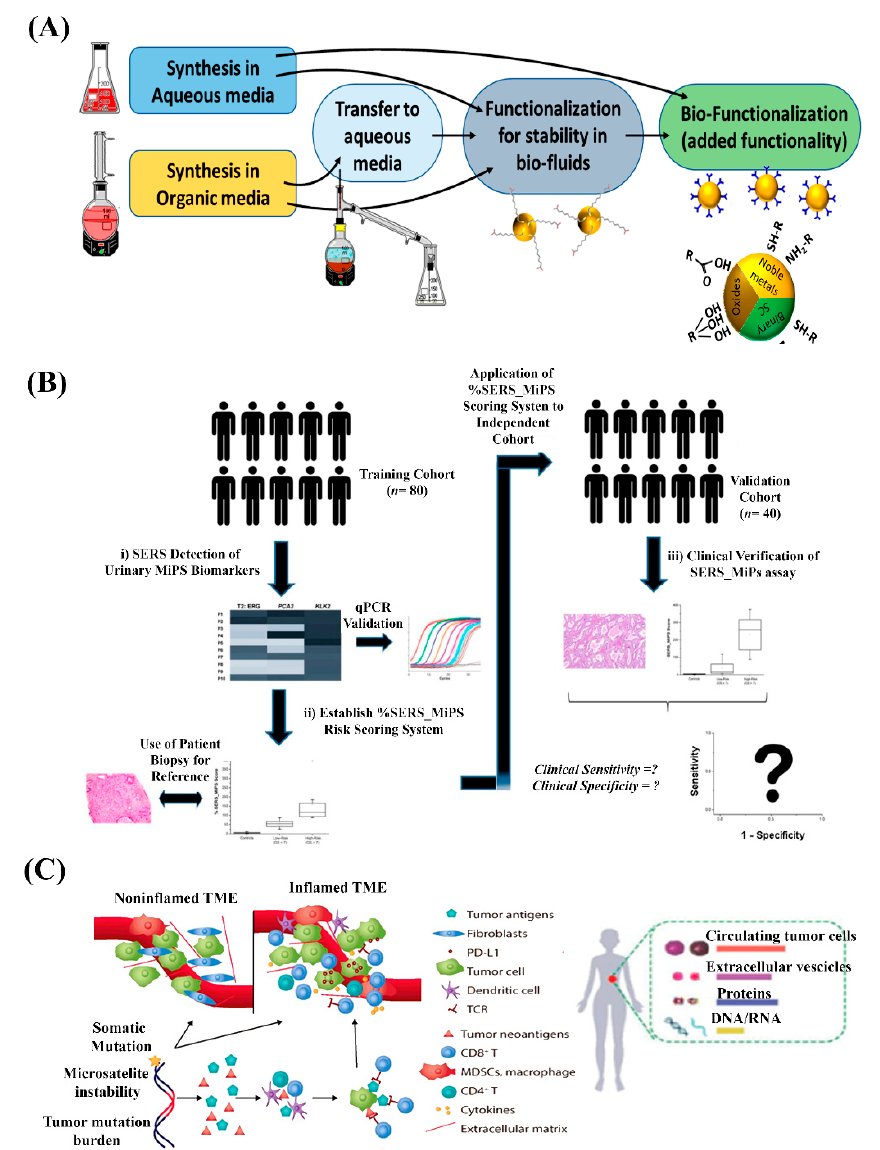
Figure 5. ( A ) Approaches for the stabilization of SERS-active nanomaterials in biofluids using functionalization of various surface ligands. Reproduced from [78], with permission from MDPI, 2018. ( B ) Clinical validation blueprint for the translation of SERS nanomaterials using a proven biomarker panel and independent training and validation patient sample cohorts. Reproduced from [81], with permission from the American Chemical Society, 2018. ( C ) The expansion of SERS-active nanomaterial usage for an entire repertoire of molecular immunomarker species (cells, DNA, RNA, proteins, etc.) in the tumor microenvironment. Reproduced from [16], with permission from the American Association for Cancer Research, 2018.